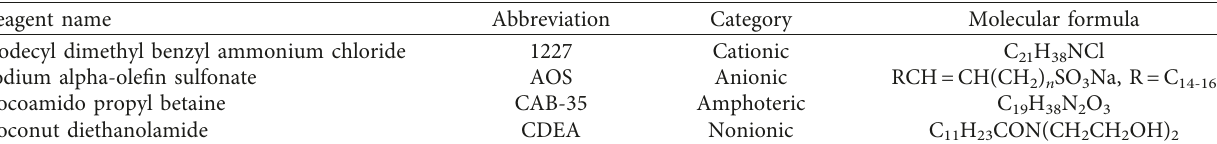
Table 1: The surfactants used in the experiment.